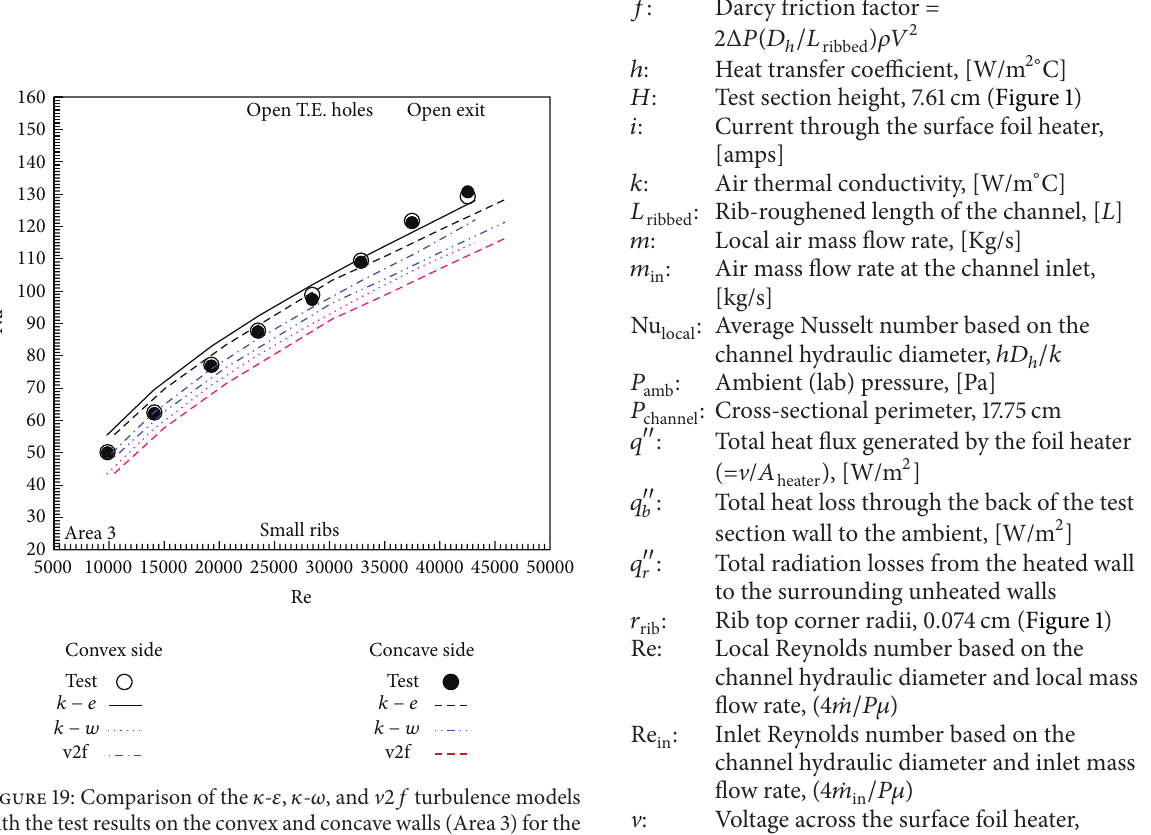
Figure 18: Measured Nusselt number variation with the local Reynolds number on all areas on the convex wall for the two rib geometries, open trailing-edge holes, and closed channel exit.